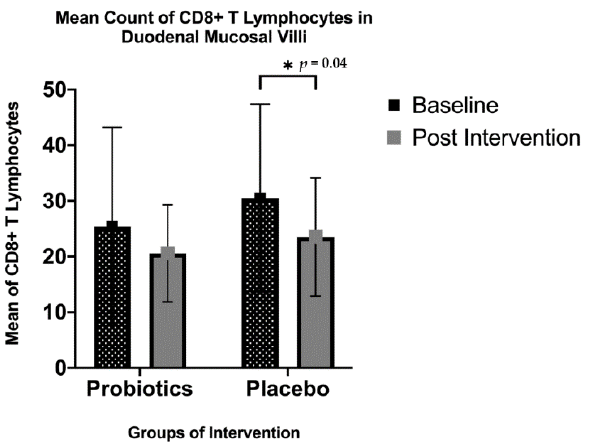
Figure 4. Immunohistochemical staining of CD8+ protein in the duodenal mucosa (CD8+,400X). ( a ) Duodenal mucosa of a patient with NAFLD at baseline. ( b ) Duodenal mucosa of a patient with NAFLD after 6 months of probiotics. ( c ) Duodenal mucosa of a patient with NAFLD at baseline. ( d ) Duodenal mucosa of a patient with NAFLD after 6 months of the placebo. Red arrows show brownish CD8+ T lymphocytes in the lamina propria. Semi-quantitatively, no significant post- intervention difference was seen in either the probiotics of placebo groups. Staining score: 0: no staining; +: focal staining; ++: regional staining; and +++: no loss.